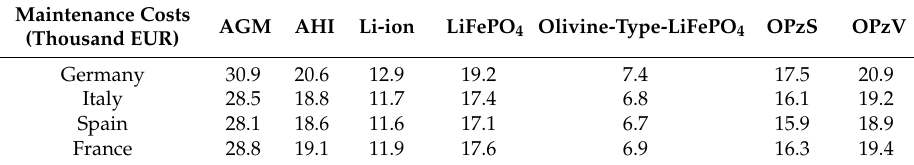
Table 4. Calculated maintenance costs for different battery types in the studied